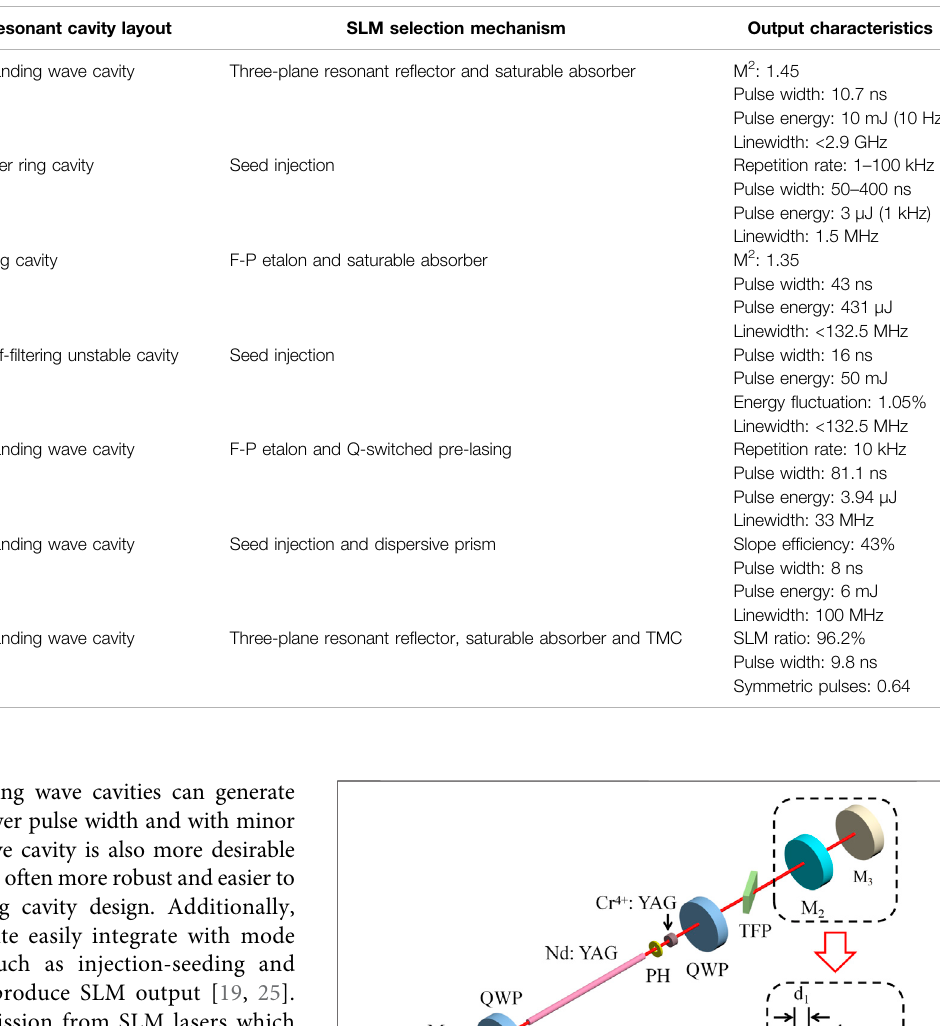
TABLE 1 | Summary of recently reported SLM lasers.